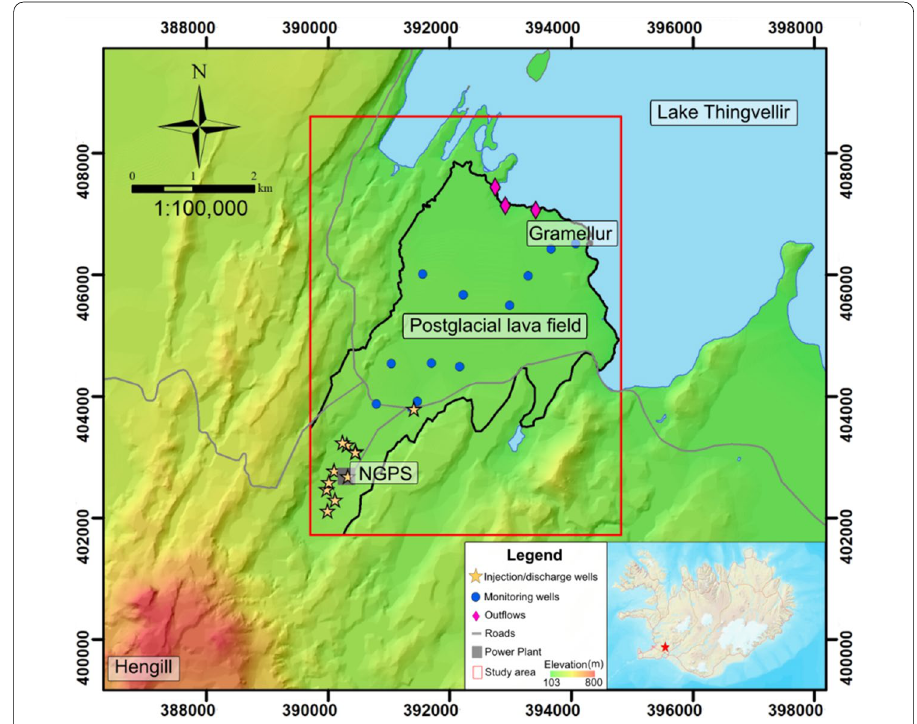
Fig. 1 Location of the Nesjavellir geothermal field. Red box is the study zone, and the main area of interest is within the post‑glacial lava field outlined by the black line. NGPS: Nesjavellir Geothermal Power